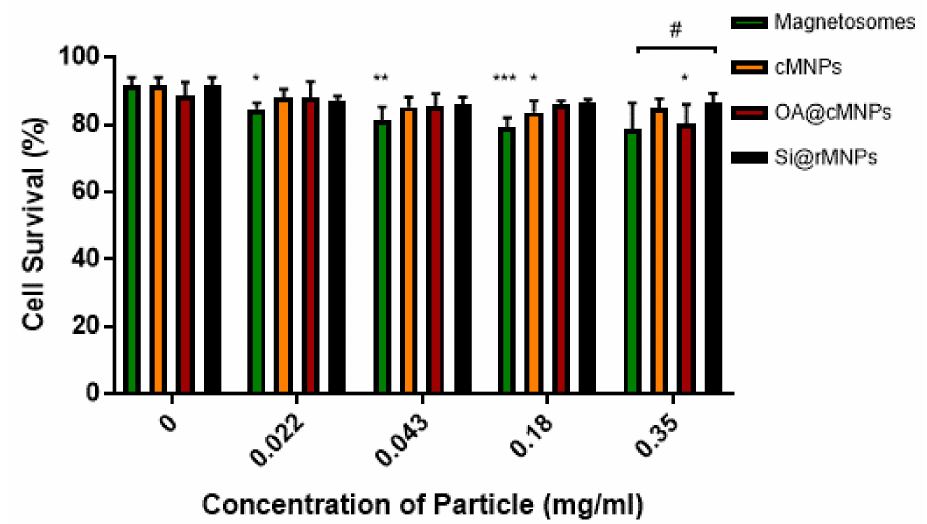
Figure 6. Cell viability as determined by flow cytometry 24 h after treatment with magnetosomes (green), Si@rMNP (black), Si@cMNP (orange), and OA@MNP (red) at increasing concentrations. * p < 0.05, ** p < 0.01, *** p < 0.001 compared to the control for each group, # p < 0.05 compared particle concentrations to the other particles within that same concentration by